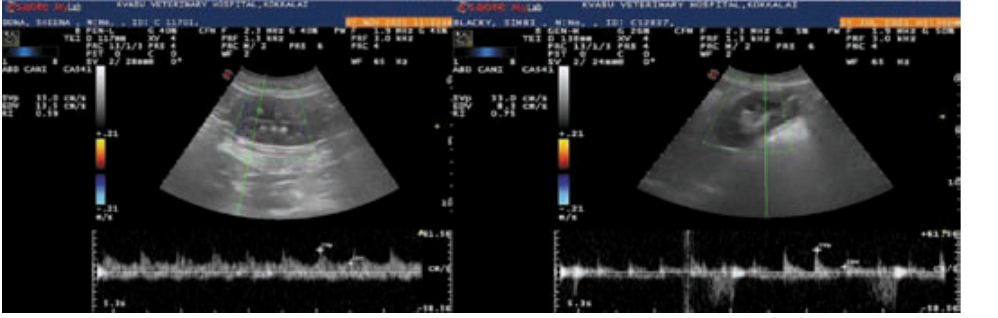
Fig. 3. Left image showing kidney of a healthy dog that is normal in size (K/Ao ratio 5.06), Renalcortex (C) is more echogenic than medulla (M) is separated by several lobulatedsegments by the presence of linear echogenicity representing borders of the interlobar vessels. Right image showing the right kidney of a dog with AKI. Renal cortex (C) is hyperechoic than liver, increased in size (K/Ao; 12.09), reduced cortico-medullary differentiation and loss in architecture.